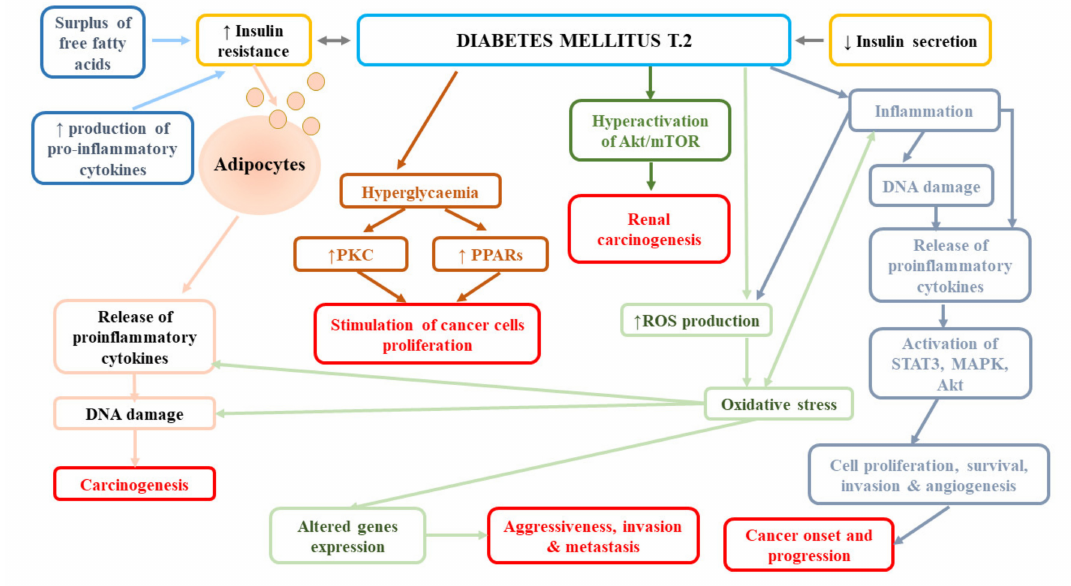
Figure 3. Pathomechanisms related to cancer development and progression in diabetes mellitus. Akt, protein kinase B; MAPK, mitogen-activated protein kinase; PKC, protein kinase C; PPARs, peroxisome proliferator-activated receptors; ROS, reactive oxygen species; STAT3, signal transducer and activator of transcription